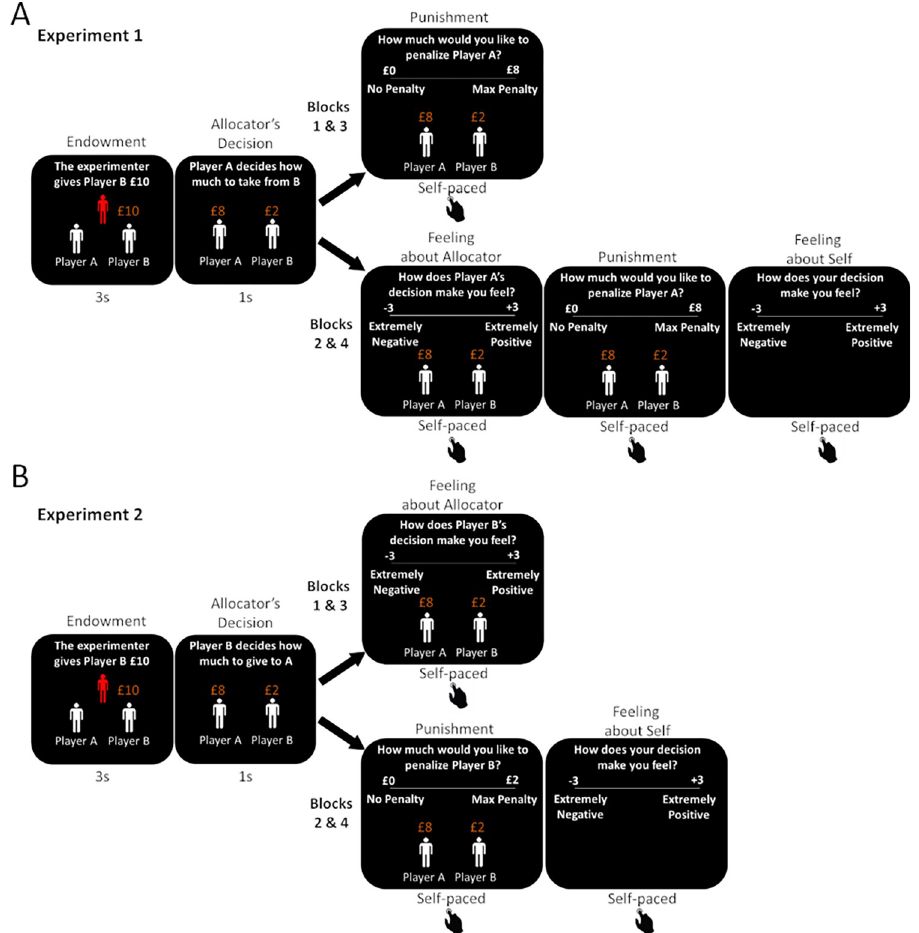
their punishment